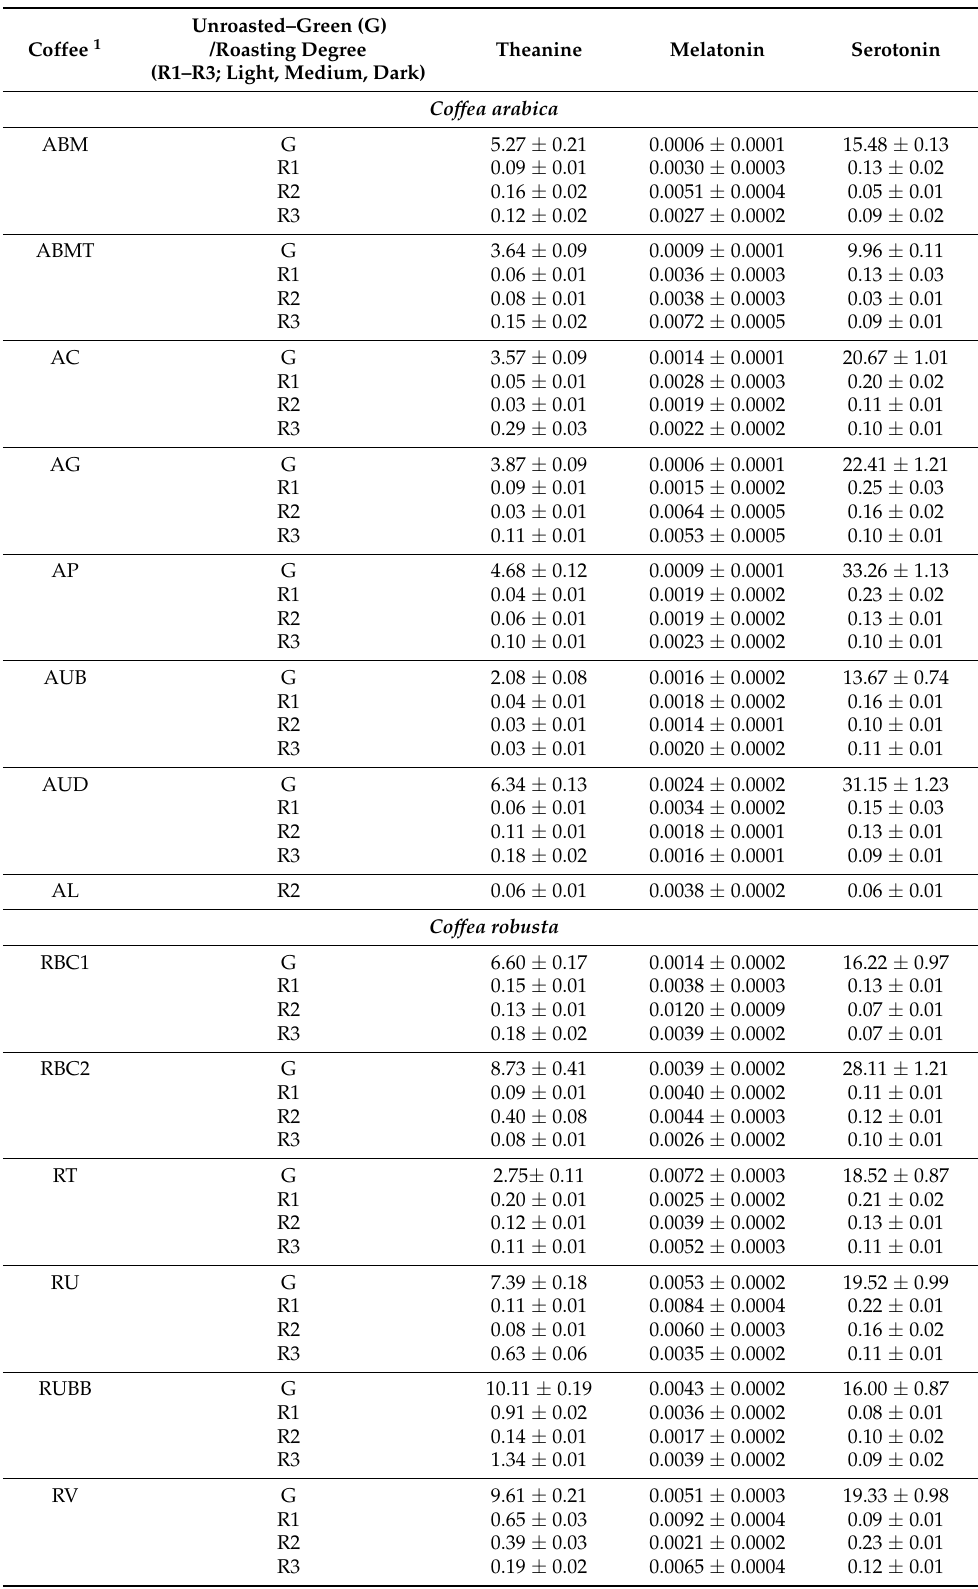
Table 2. Theanine, melatonin, and serotonin content in Arabica and Robusta coffee brews ( µ g g − 1